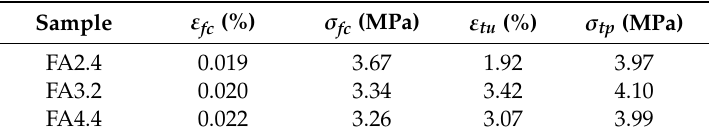
Figure 7. Measured stress-strain curves of HVFA-SHCC samples. ( a ) FA2.4; ( b ) FA3.2; ( c ) FA4.4. Table 5. Direct tensile test results.